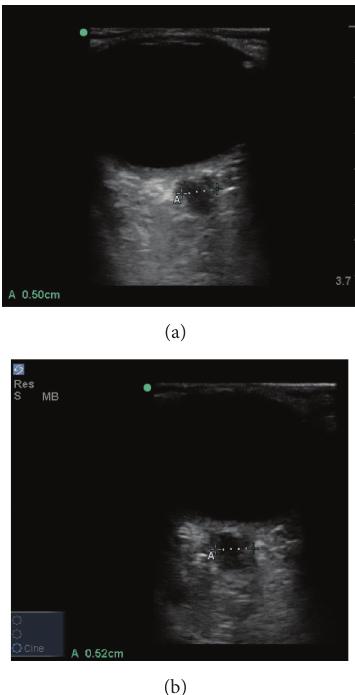
Figure 3: Bedside ocular ultrasound of left (a) and right (b) eyes, showing measurement of optic nerve sheath diameter. Measure- ments are 5 mm and 5.2 mm,